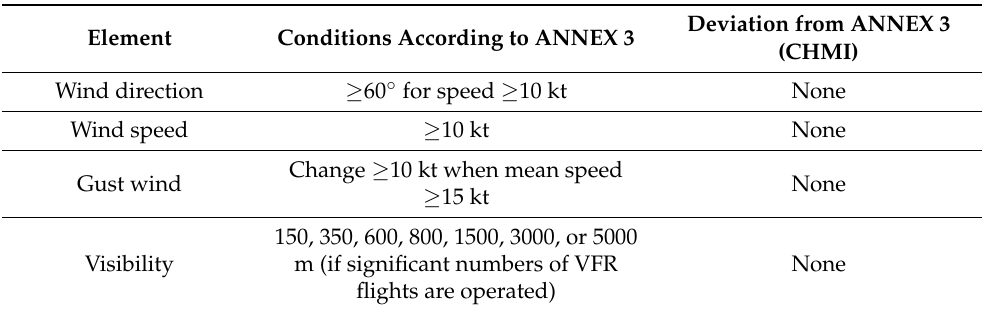
Table 3. The criteria used for the inclusion of change groups in the TAF or for the amendment of